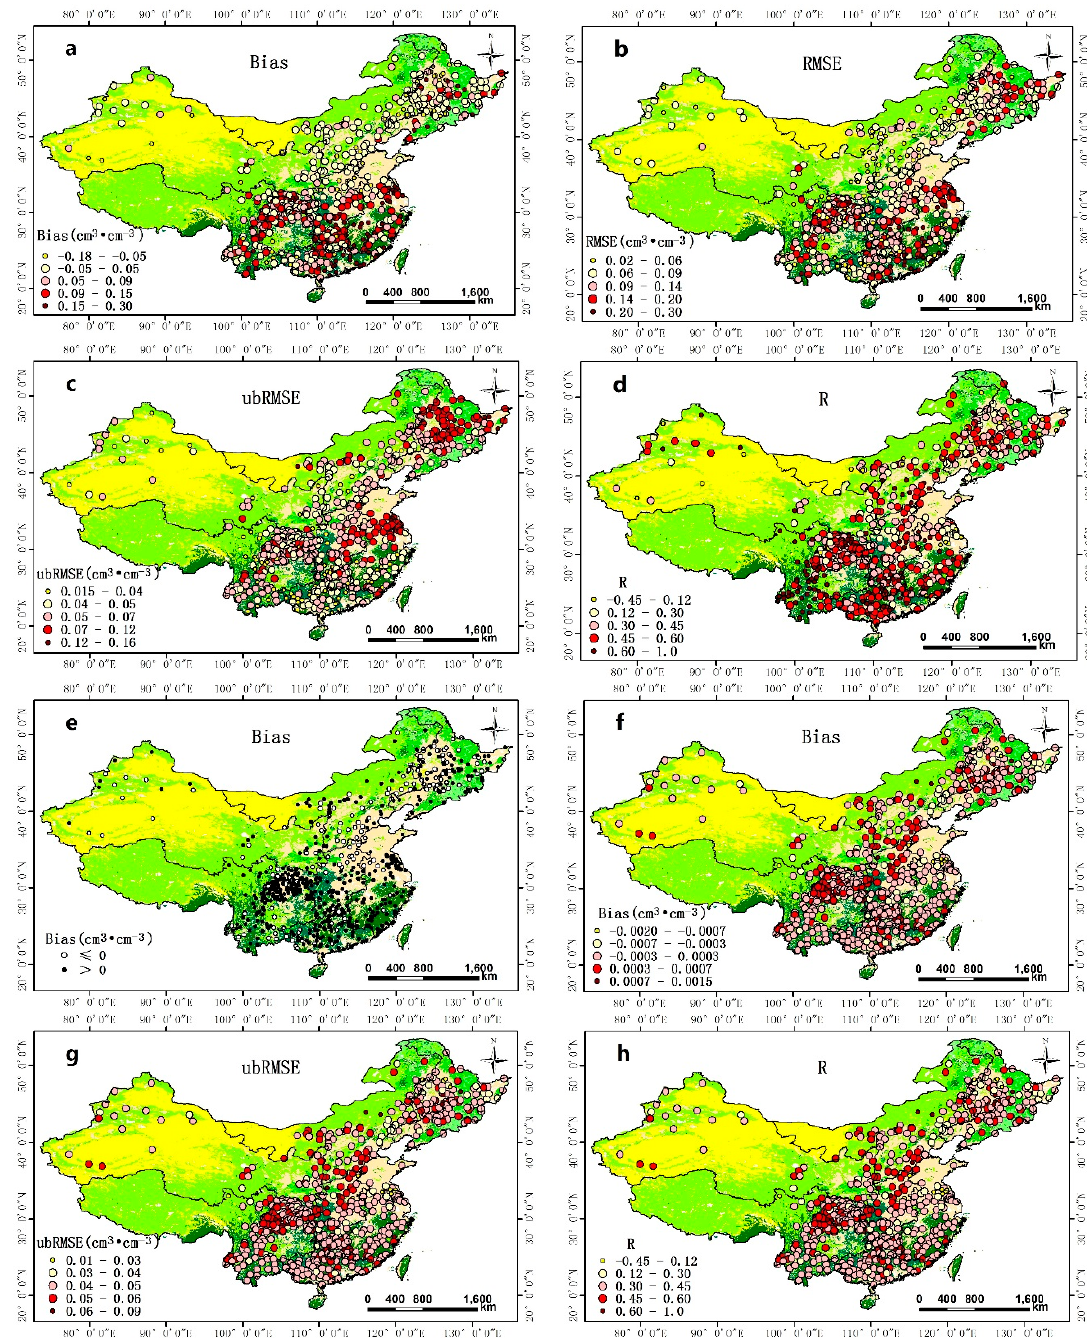
Figure 6. Spatial distribution of four metrics, i.e., bias, RMSE, ubRMSE, and R, between SMAP soil moisture retrievals and in situ observations. ( a – e ) are based on the original data; ( f – h ) are based on the anomaly data.